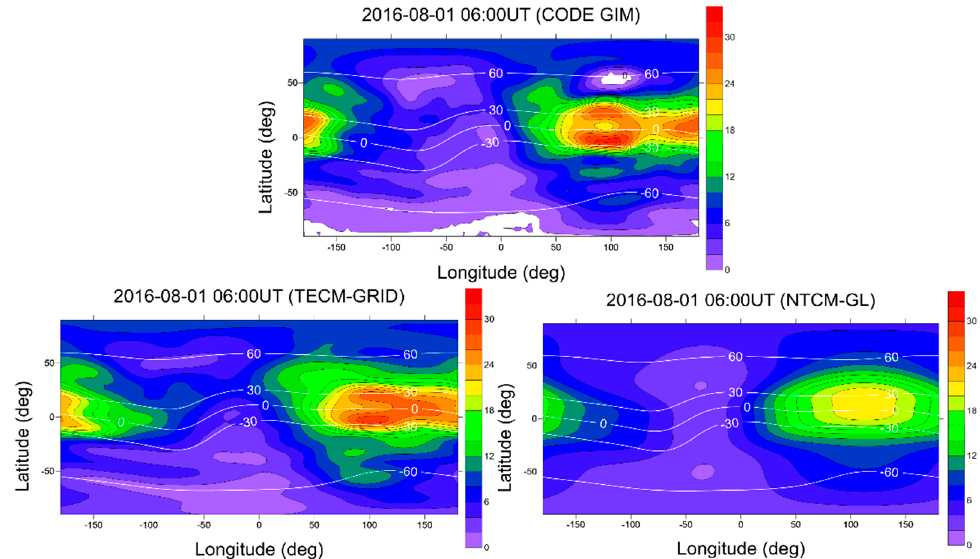
Figure 10. Comparison of TECM-GRID and NTCM-GL with the CODE GIM (1 June 2016).